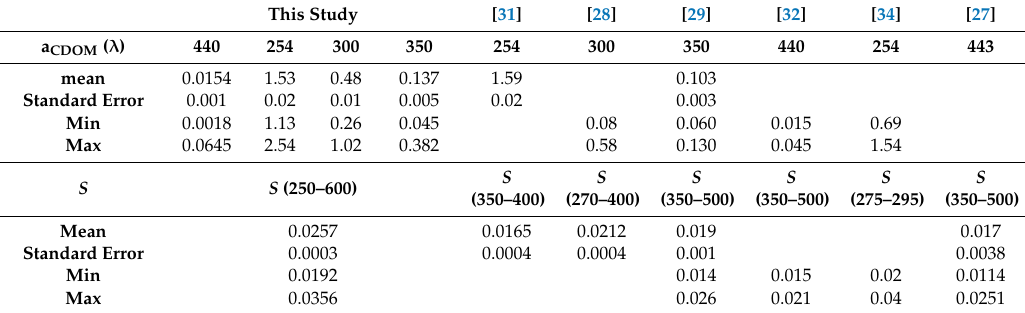
Table 2. Comparison between a CDOM ( λ ) (m − 1 ) and S (nm − 1 ) of this study and other data (references in brackets) from Mediterranean Sea. For each S is also showed the non-linear interpolation